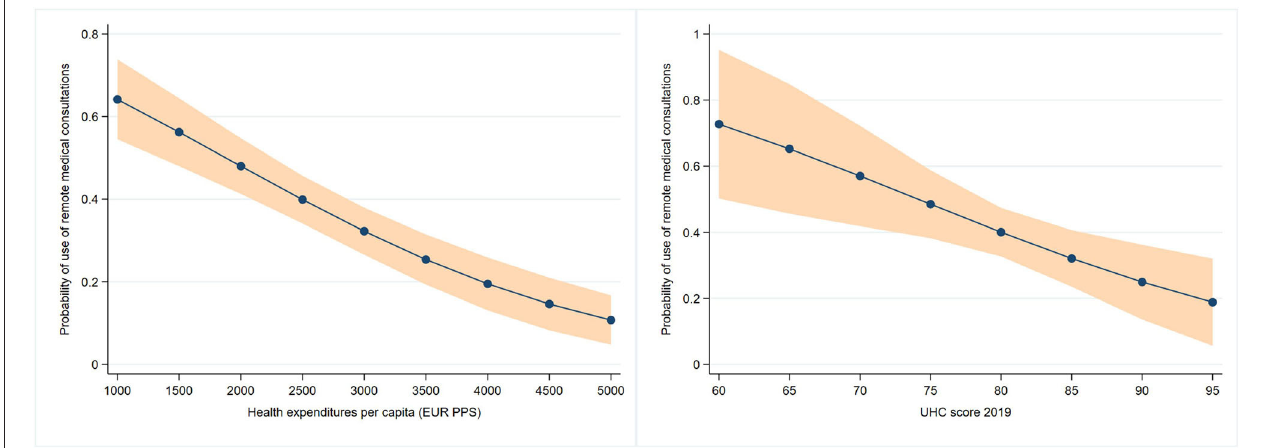
FIGURE 3 | Predictive margins at specified values of macro-level variables.